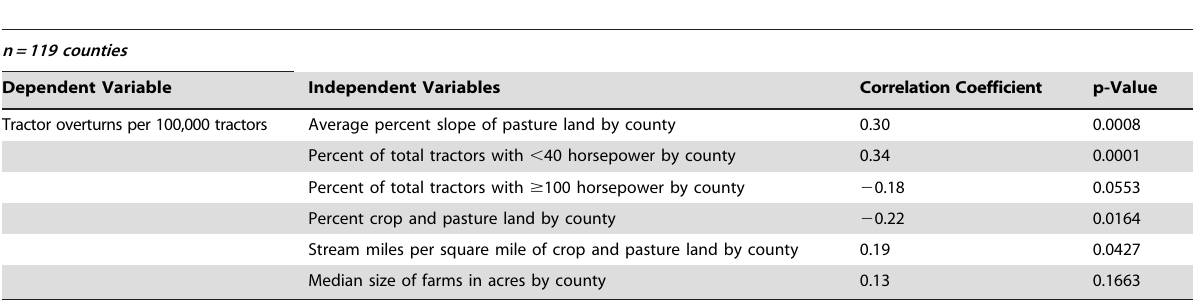
Table 4. Pearson’s correlation coefficients between tractor overturns and independent variables.